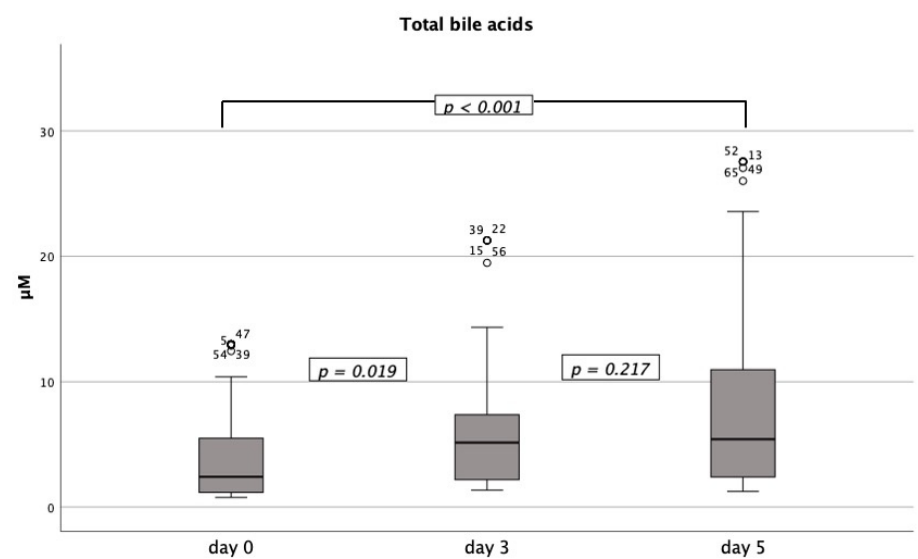
Figure 2. Evolution of total bile acids from day 0 to day 5. Levels of total bile acids were significantly correlated to GGT on day 0 and 3 and in a trend also on day 5. Table 2. Median and interquartile range for measured biomarkers as well as paO 2 levels and mean PEEP of all patients after winsorization.